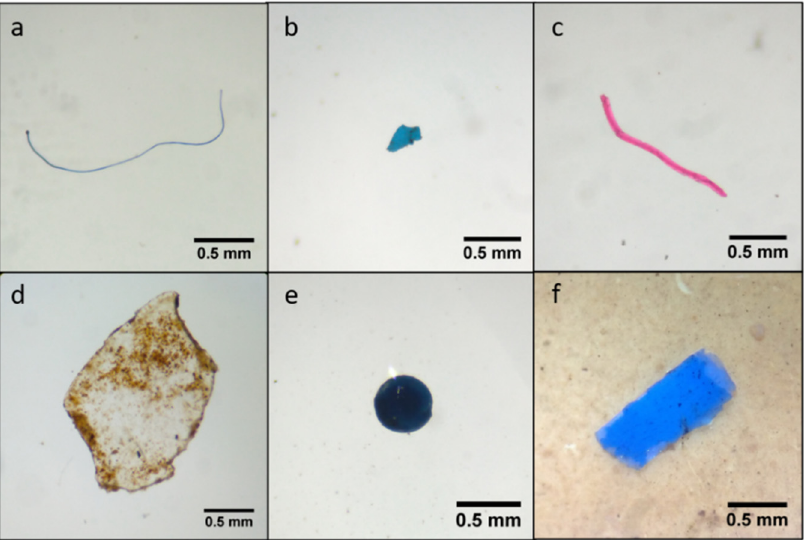
Figure 6. Representative of MPs found in the samples. Blue and red line ( a , c ), blue fragment ( b ), transparent fragment ( d ), blue pellet ( e ), and blue film ( f ) MPs.